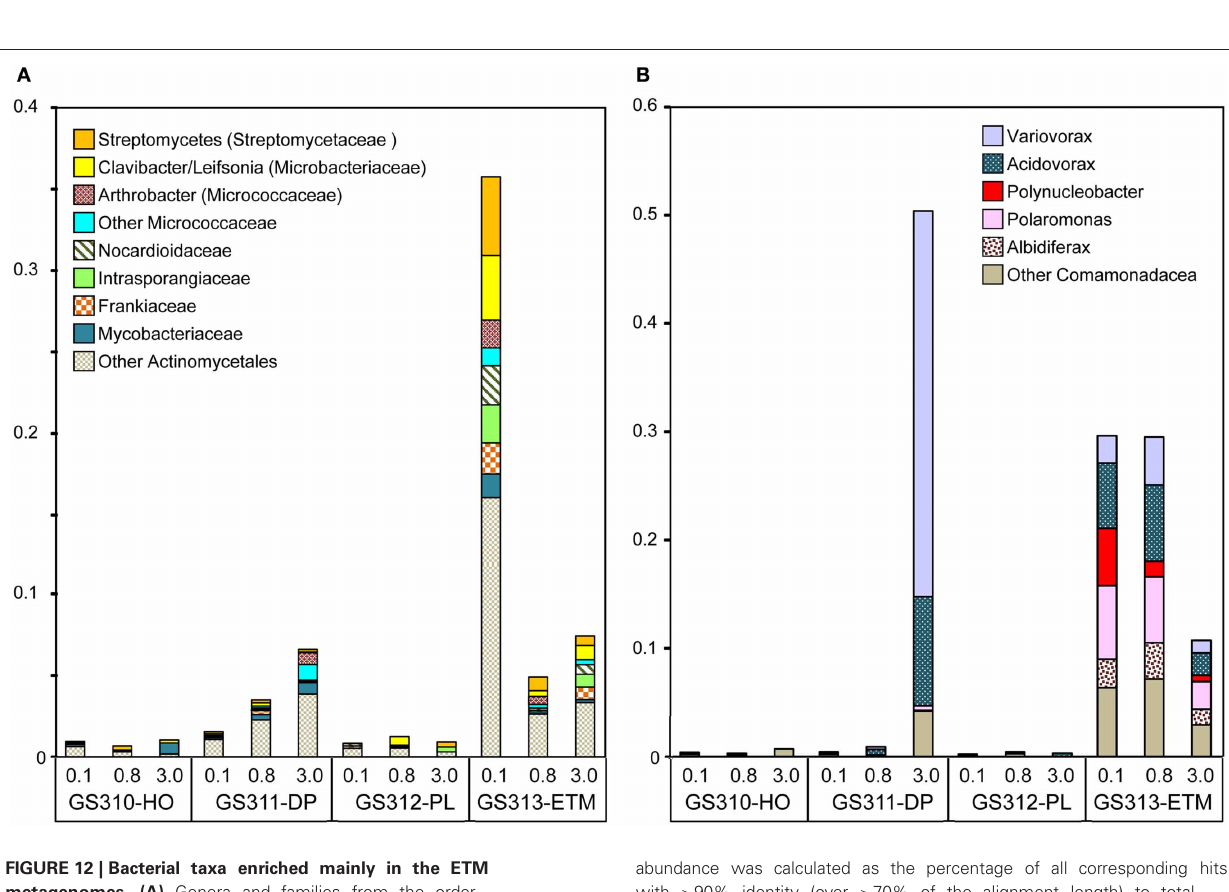
annotated prokaryotic peptides in the corresponding metagenome. Abundance values are shaded from white to black on a scale indicating percentages from low to high. Sample names are composed of the GS number, habitat (HO, hypoxic water; DP, deep ocean bottom; PL, plume; ETM, estuarine turbidity maxima), and size fraction: 0.1, 0.1–0.8 μ m; 0.8, 0.8–3 μ m; 3, 0.8–200 μ m.